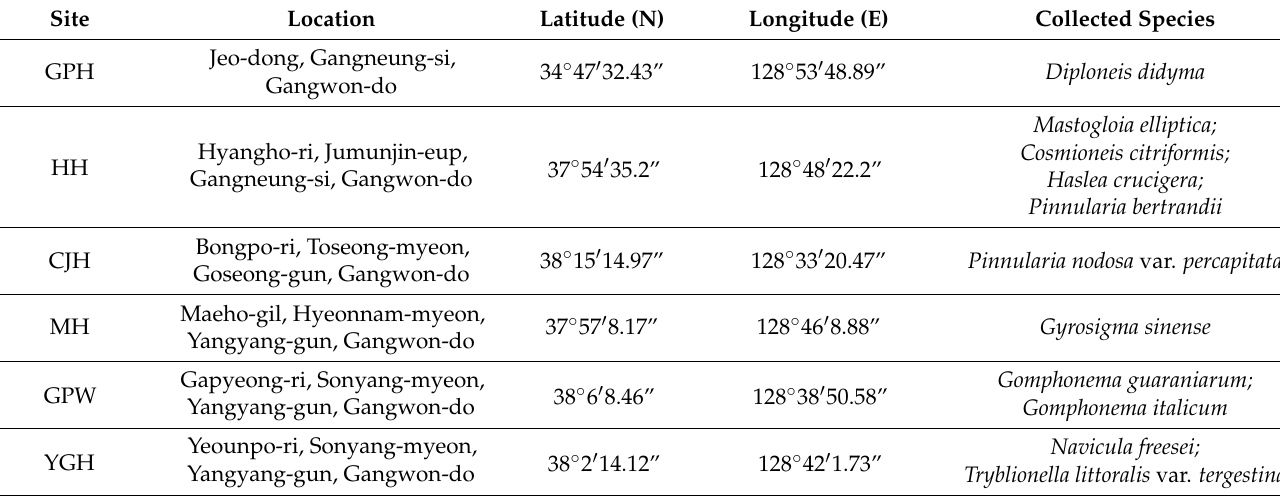
Figure 1. Sampling sites along the lagoons (CJH: Chunjinho, GPW: Gapyeongri wetland, YGH: Yeo- mgaeho, MH: Maeho, HH: Hyangho, GPH: Gyeongpoho). Table 1. Information of sampling